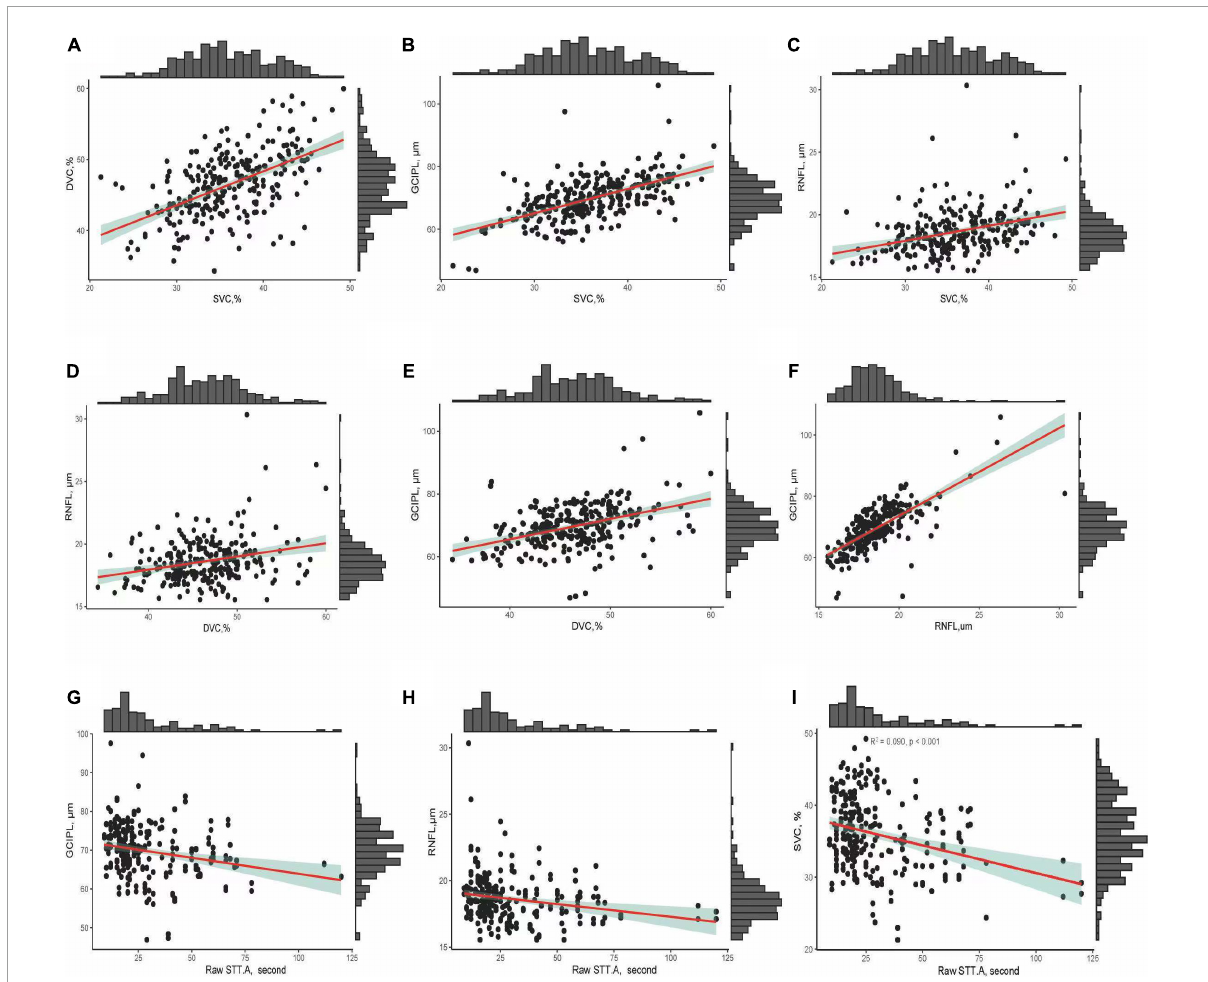
FIGURE3 (A–F) Show the correlation between OCT/OCTA parameters. (G–I) Show the correlation between OCT/OCTA parameters and STT-A without adjusting for risk factors.